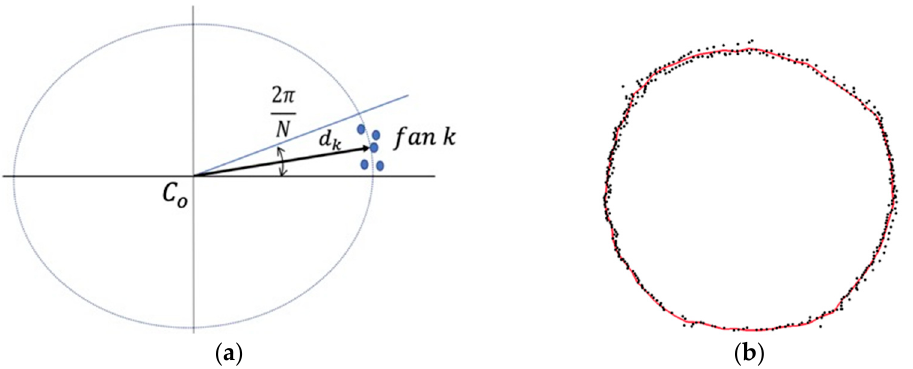
Figure 11. Ellipses detected from point-clouds.